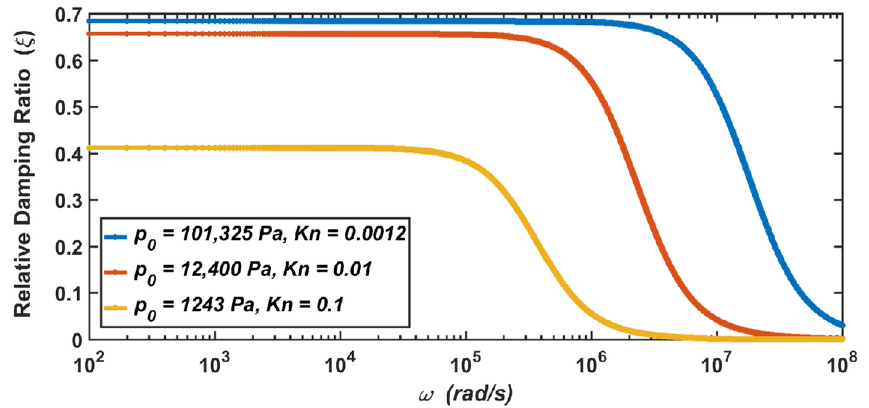
Figure 6. The dependence of the relative damping ratio of the micro-accelerometer on the vibration frequency when the air pressure drops from the standard atmospheric pressure to 1243 Pa.